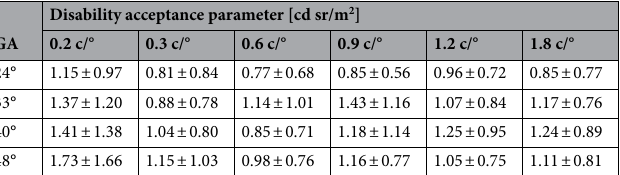
Table 3. Mean ± standard deviation in [cd sr/m 2 ] of the DA parameter for all spatial frequencies and angular sizes of the glare